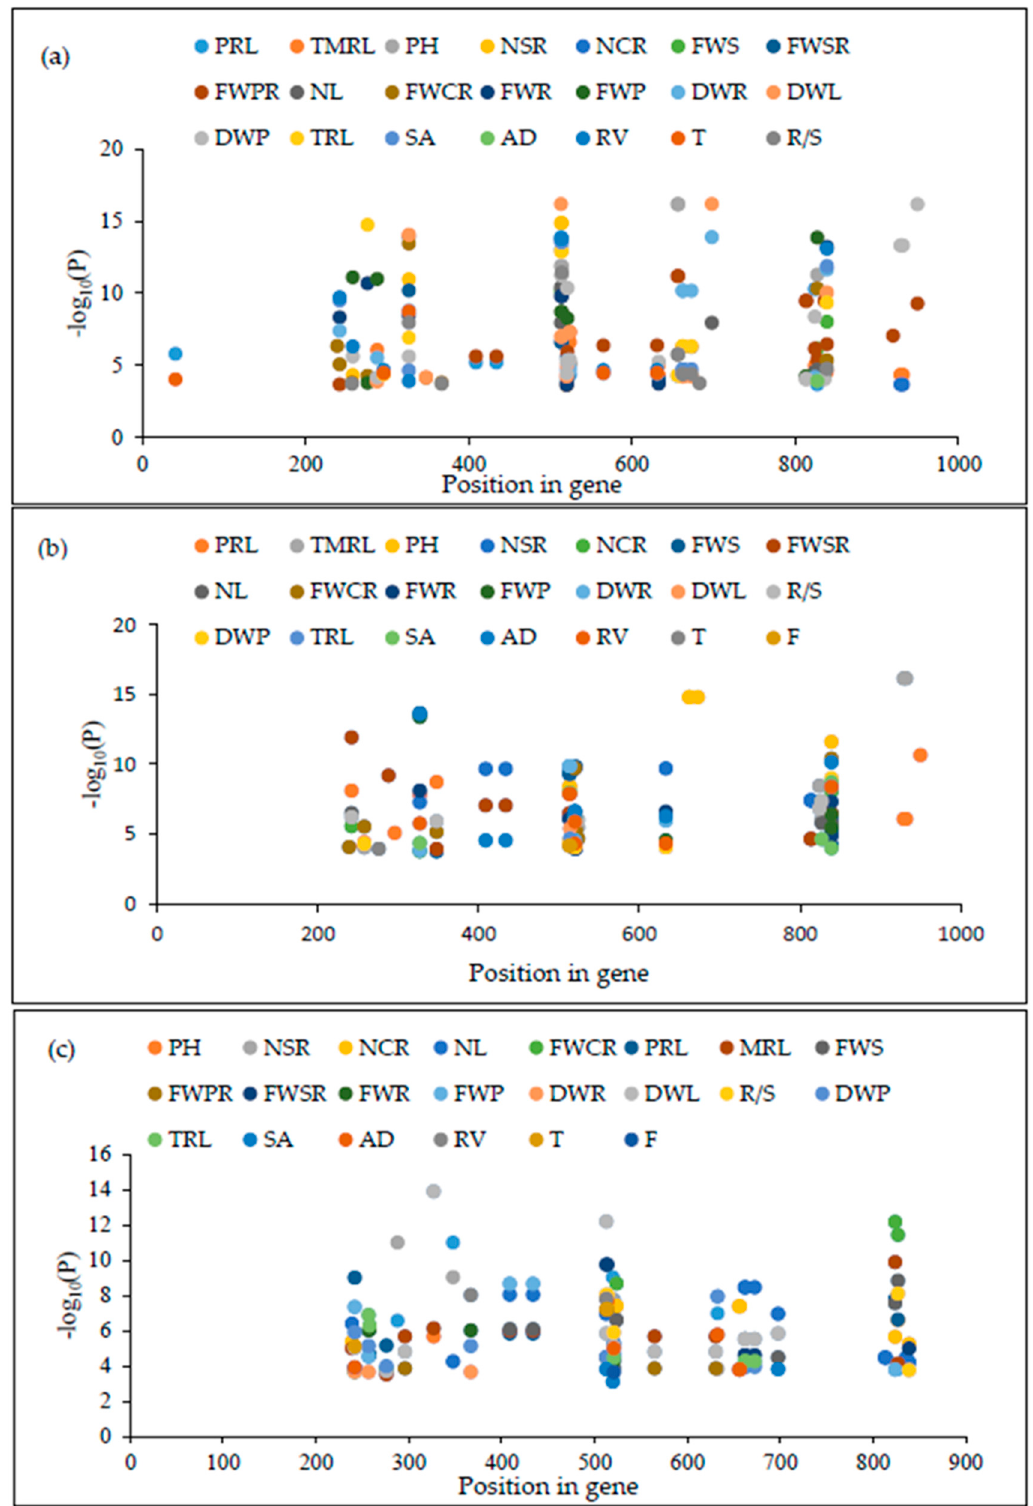
Figure 6. Association analysis of polymorphic sites of ZmNAC19 and low-phosphorus tolerance seedling traits at threshold (–log P value 3.43). ( a ) Polymorphic sites with low-phosphorus (P) tolerant trait index; ( b ) polymorphic sites with low-P tolerant trait under normal-P conditions; ( c ) polymorphic sites with low-P tolerant trait under low-P conditions.